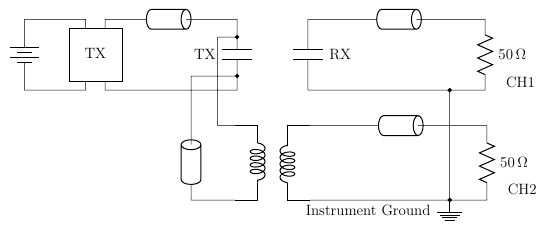
Figure 4: Experiment schematic diagram. The transmission lines shown are 50 Ω cables. Each 50 Ω resistor represents the input stage of the oscillo- scope.